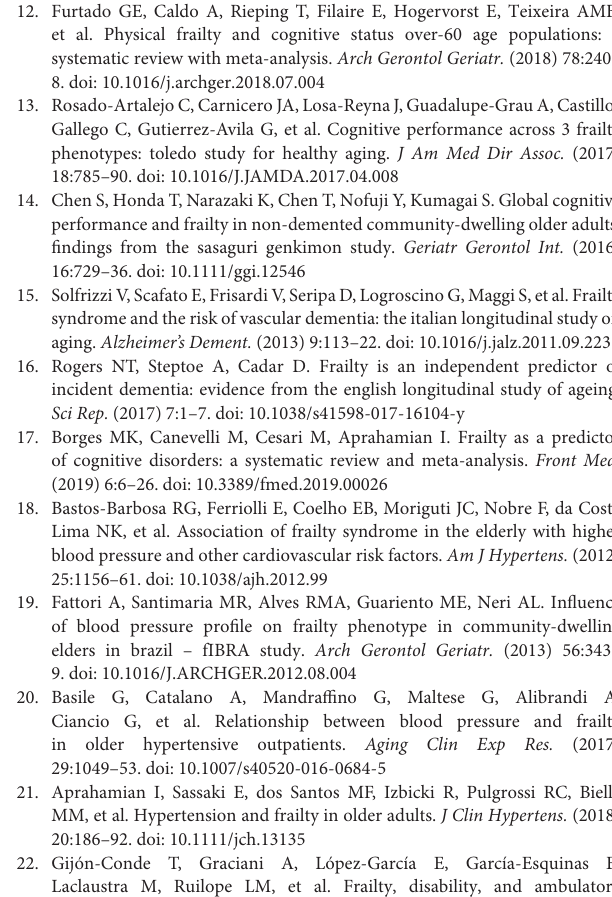
Supplementary Figure 1 | Effects of RT on physical performance in prefrail older adults. LSRT, Low-speed resistance training; HSRT, High-speed resistance training; CG, Control group. 6MWT, 6-minute walking test; IHG, Isometric handgrip strength; TUG, Timed “Up and Go”; WS, Walking speed; a P < 0.05 vs. Pre-intervention; b P < 0.05 vs. LSRT; c P < 0.05 vs. HSRT. Supplementary Figure 2 | Effects of RT on physical performance in frail older adults. LSRT, Low-speed resistance training; HSRT, High-speed resistance training; CG, Control group. 6MWT, 6-minute walking test; IHG, Isometric handgrip strength; TUG, Timed “Up and Go”; WS, Walking speed; a P < 0.05 vs. Pre-intervention; b P < 0.05 vs. LSRT; c P < 0.05 vs.